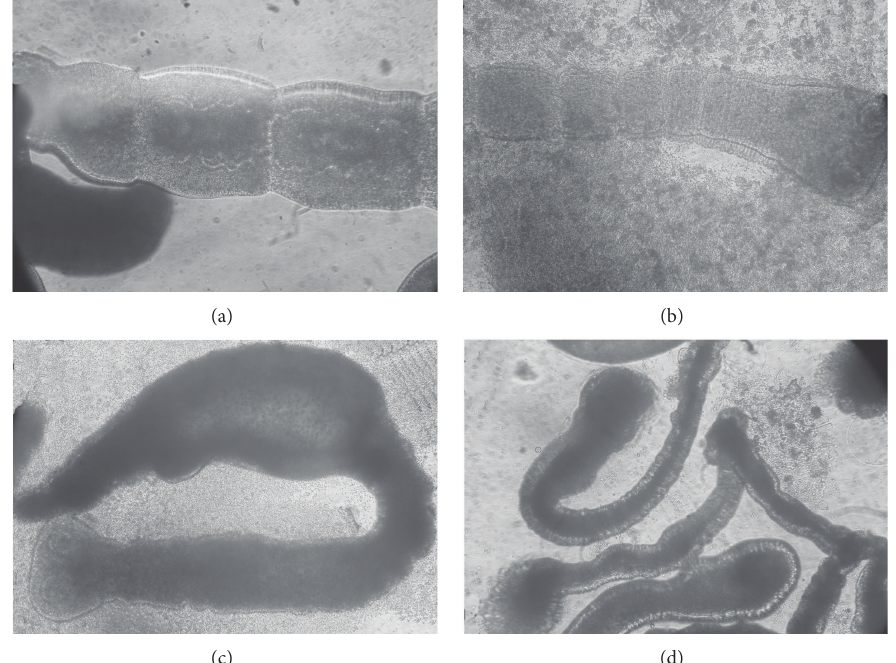
Figure 3: Inverted optical microscope of Mesocestoides corti adult worms incubated in vitro with thymol. (a) Control adult worm (100x). Partial view of a strobila. (b) Altered adult worm after 10min of incubation with thymol (250 𝜇 g/mL). The tegument is altered and debris of tegument could be observed in the culture medium (100x). (c) Adult worm (10min, 200 𝜇 g/mL). Note the tegumental damage and the influx of culture medium into the worm (100x). (d) Adult worms after 30 min of incubation with thymol (150 𝜇 g/mL). Note the tegumental alterations with the presence of blebs and loss of morphology